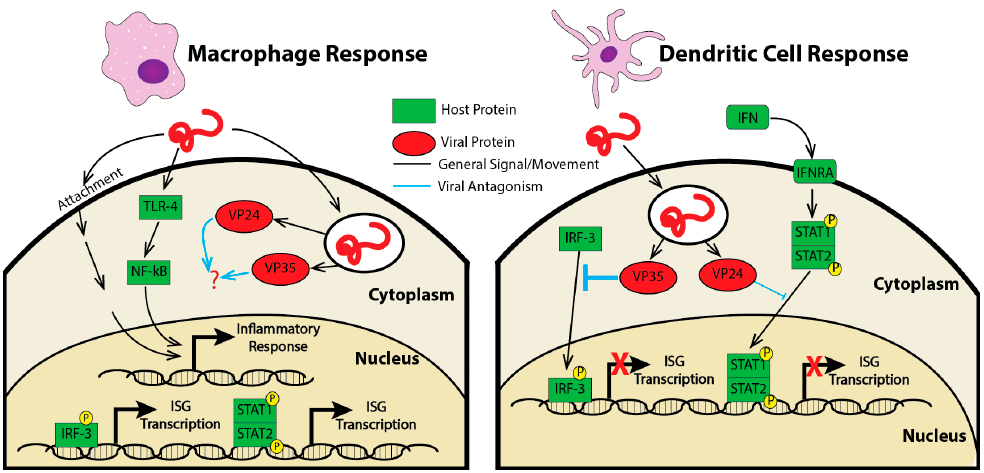
Figure 2. Virus–host antagonism following EBOV infection of macrophages or dendritic cells. Left panel illustrates the response to EBOV entry and attachment in macrophages. Upon attachment, activation of tool like receptor 4 (TLR-4) and nuclear factor kappa B (NF- κ B) by the entry process lead to the induction of inflammatory transcripts. IRF3/IFN-induced genes are also induced in macrophage-infected cells, suggesting that the function of VP24 and VP35 as viral antagonists of these signaling pathways is compromised or that other signaling pathways are activated. The right-hand panel illustrates the interaction of EBOV and the host-response in dendritic cells. Similar to what is seen in many immortalized cell lines, VP35 will act as a strong inhibitor of IRF-3 phosphorylation blocking interferon and ISG transcription. Also, VP24 will act as an inhibitor of translocation of pSTAT1/2 to the nucleus further blocking interferon transcription.